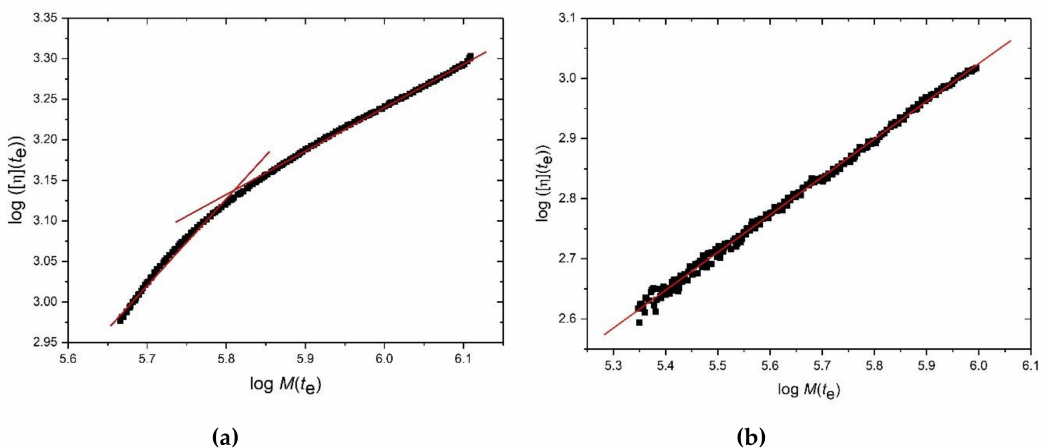
Figure 5. Mark–Houwink–Kuhn–Sakurada plots of log intrinsic viscosity vs log molecular weight M ( t e ) at corresponding elution times t e : ( a ) hyaluronic acid and ( b ) tamarind seed gum. Solution pH = 6.8, I = 0.1, temperature = (20.0 ± 0.1) ◦